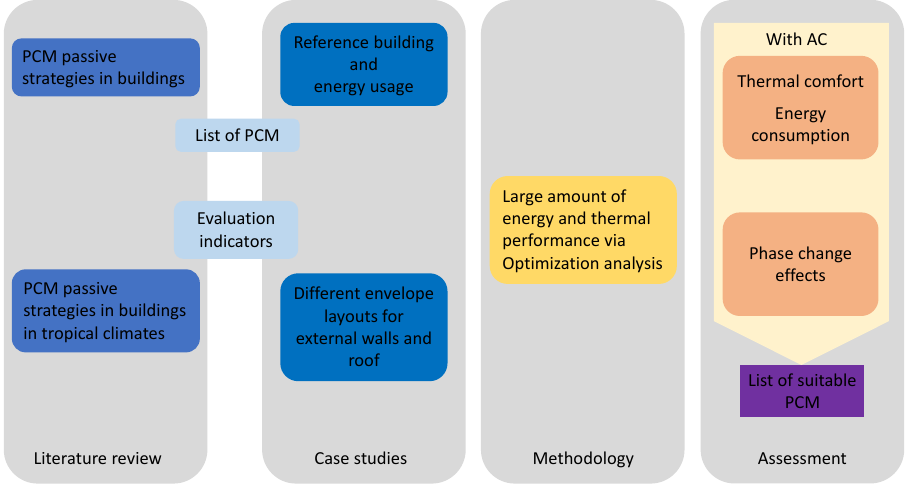
Figure 1. Research flow followed through this